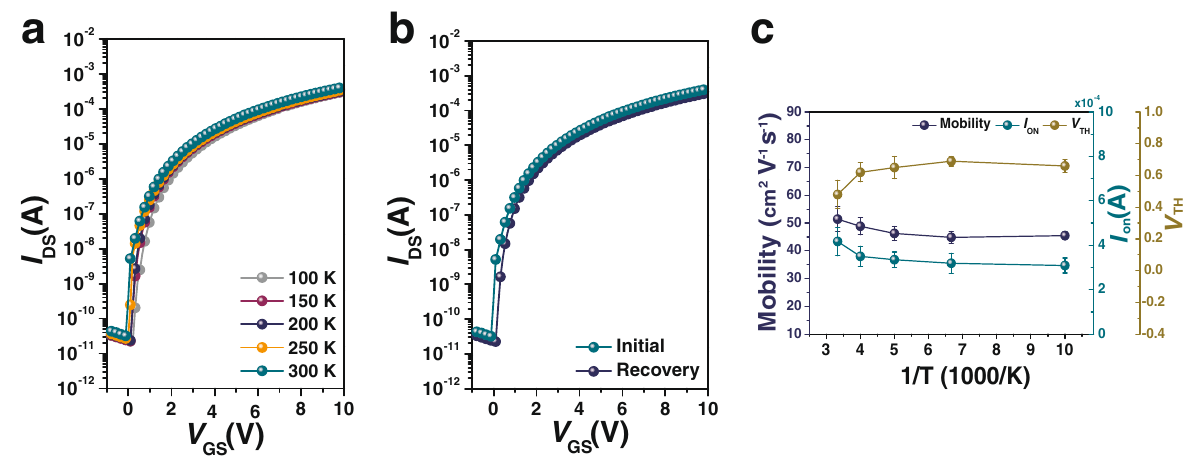
Fig. 6 | Temperature-dependent characteristics of In 2 O 3 /ZnO heterojunction TFTswithHyb_2asagatedielectric. Temperature-dependenttransfercurve a for the measurement temperature increased from 100 to 300K in steps of 50K and b for comparison of transfer curves at room temperature before and after the